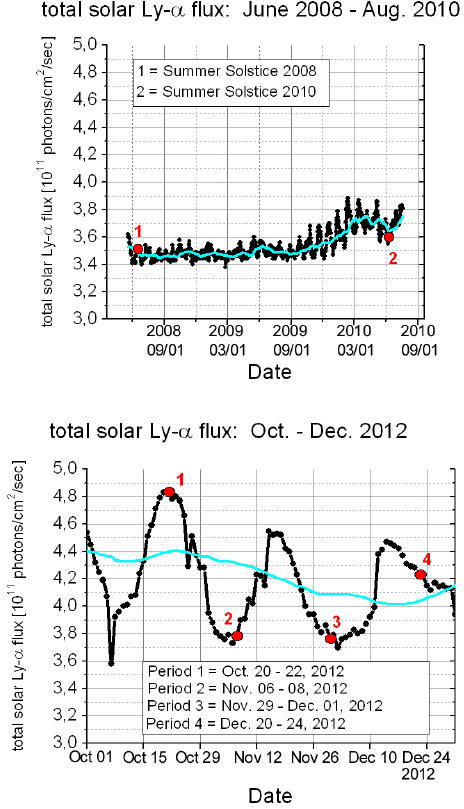
Figure 6. Total solar Lyman- α flux for the period of the solar min- imum data set (top) and the solar maximum data set (bottom). The cyan lines show the 27-day average of the